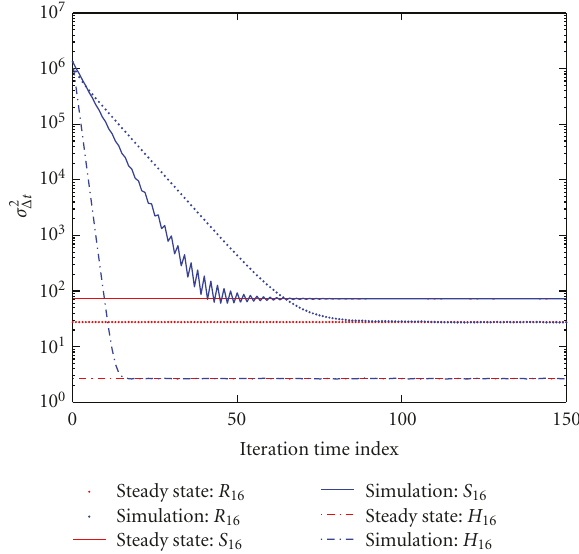
The star network S n is time delay unbalanced. Further-